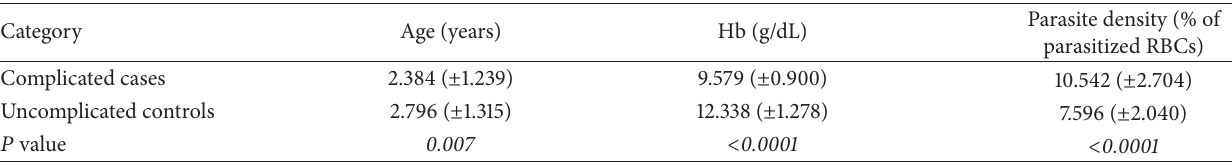
Table 1: Characteristics of